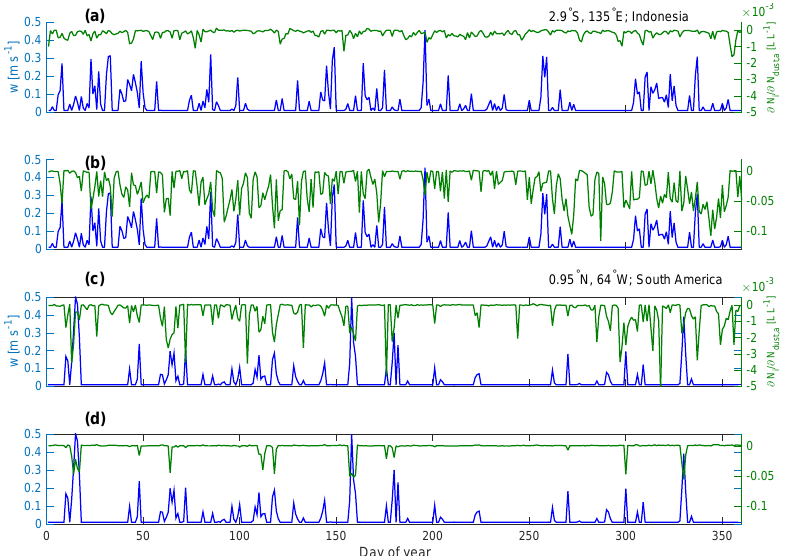
Figure 6. Time series of accumulation-mode dust number sensitivities (green, in LL − 1 ) and input updraft velocities (blue, in ms − 1 ) over Indonesia at 2.9 ◦ S, 135 ◦ E for (a) PDA08 and (b) PDA13; and over South America at 0.95 ◦ N , 64 ◦ W for (c) PDA08 and (d)